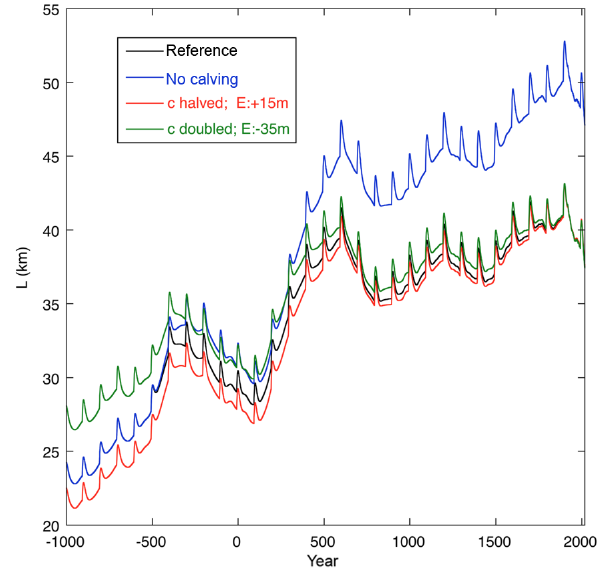
Figure 8. Sensitivity of glacier length to a larger balance gradient ( β = 0 . 0065 instead of 0 . 0045mw . e . a − 1 m − 1 ) . The reference run is shown in black, the result for the larger gradient in blue. The red curve shows the result after the model has been recalibrated by adjusting the values of E 0 and E 1 . The dashed curve shows a run in which surging has been switched off (but all other parameters as for the reference run).